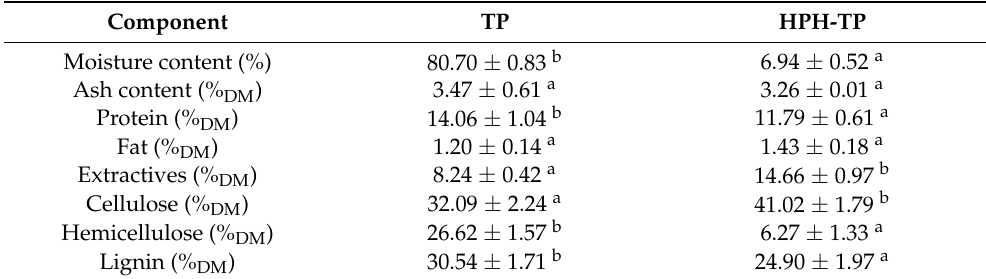
Table 2. Chemical composition of fresh tomato pomace (TP) and freeze-dried HPH-treated tomato pomace